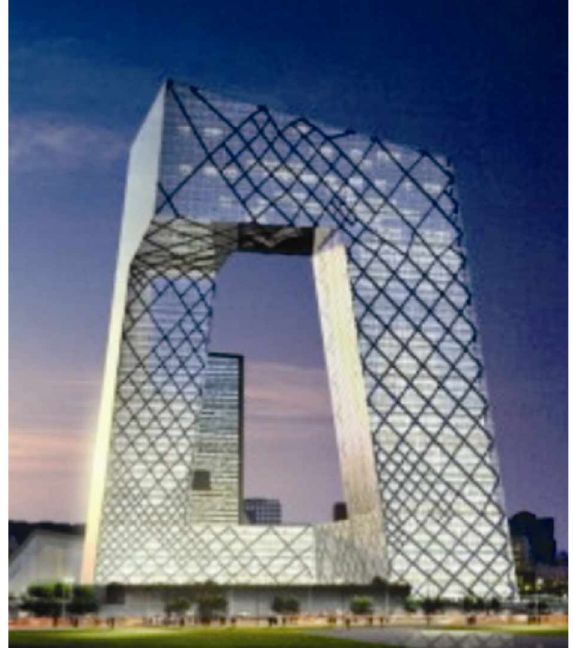
Fig. 3. The use of LSB system in Swiss Re, London (Leonard